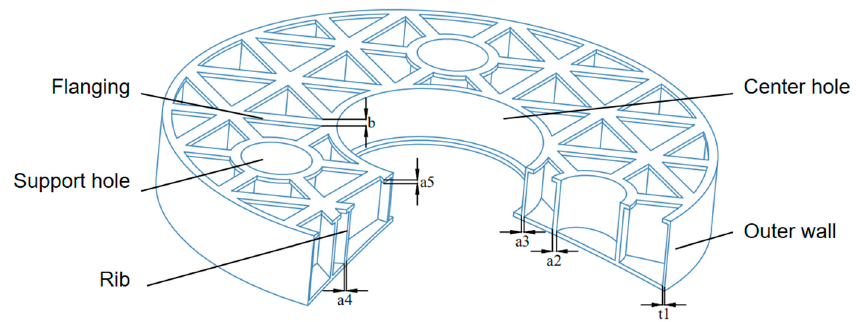
Figure 1. Semienclosed initial mirror model.